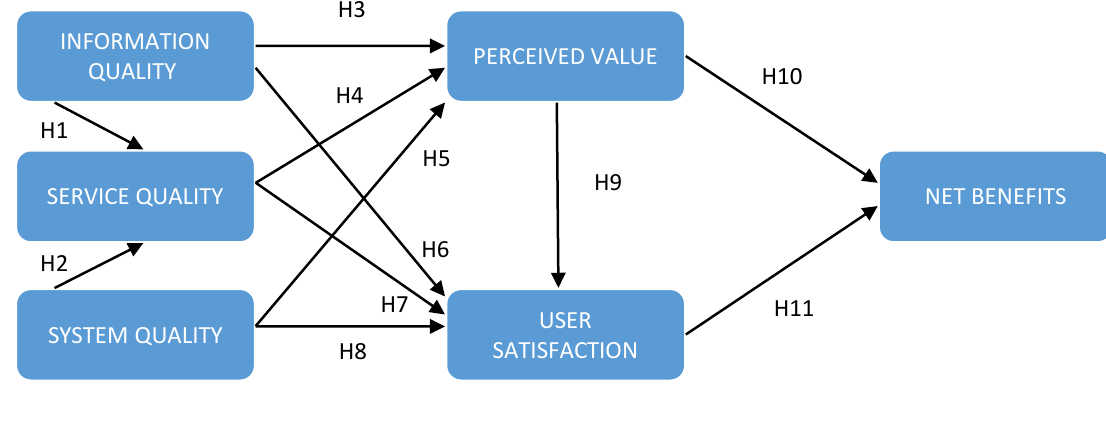
Figure 3. The research